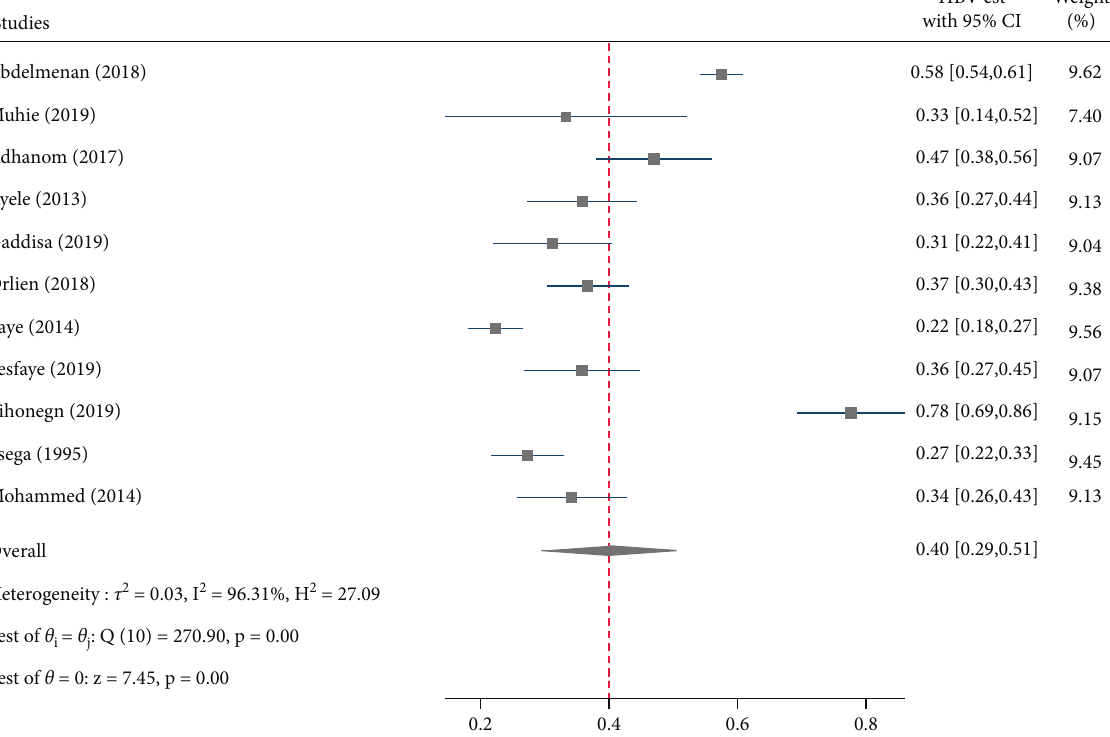
Figure 6: Forest plot depicting the estimated proportion of HBV infection among chronic liver disease patients in Ethiopia, 2021.